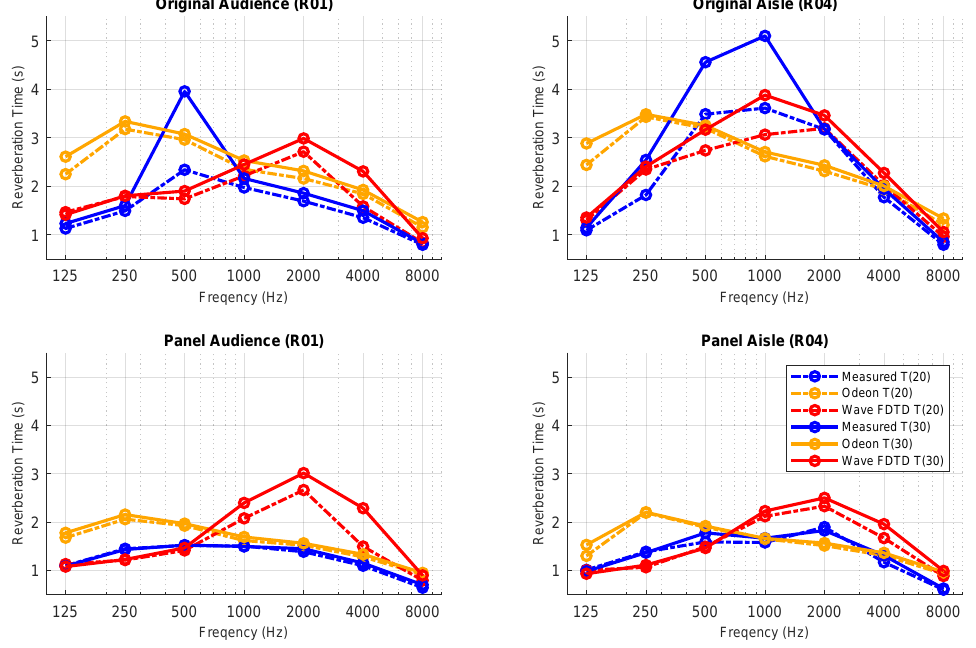
Figure 9. Reverberation times for receiver locations R01 (audience, 3m from source) and R04 (aisle, 3m from source); before and after the addition of the acoustical